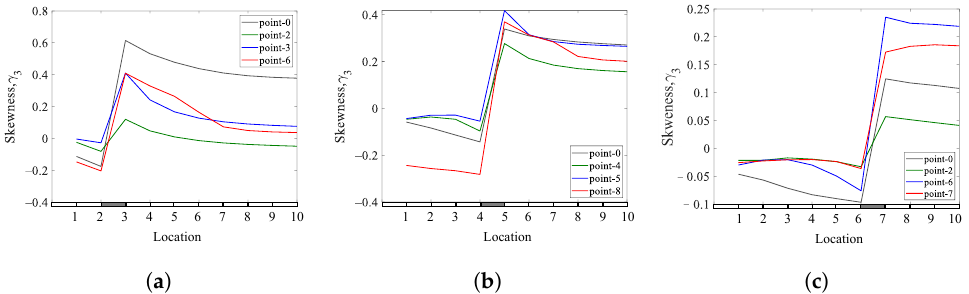
Figure 26. The effect of changing excitation locations on the skewness coefficients of a cantilever beam with a single breathing crack: ( a ) q 1 = 0.25; ( b ) q 2 = 0.45; ( c ) q 3 = 0.65.